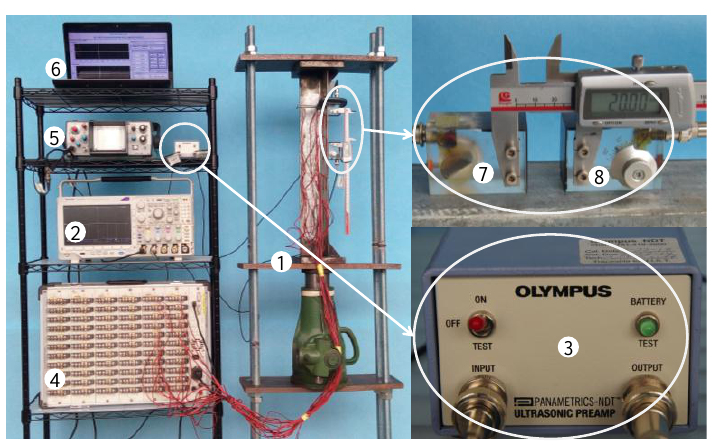
Figure 2. Measurement hardware system.